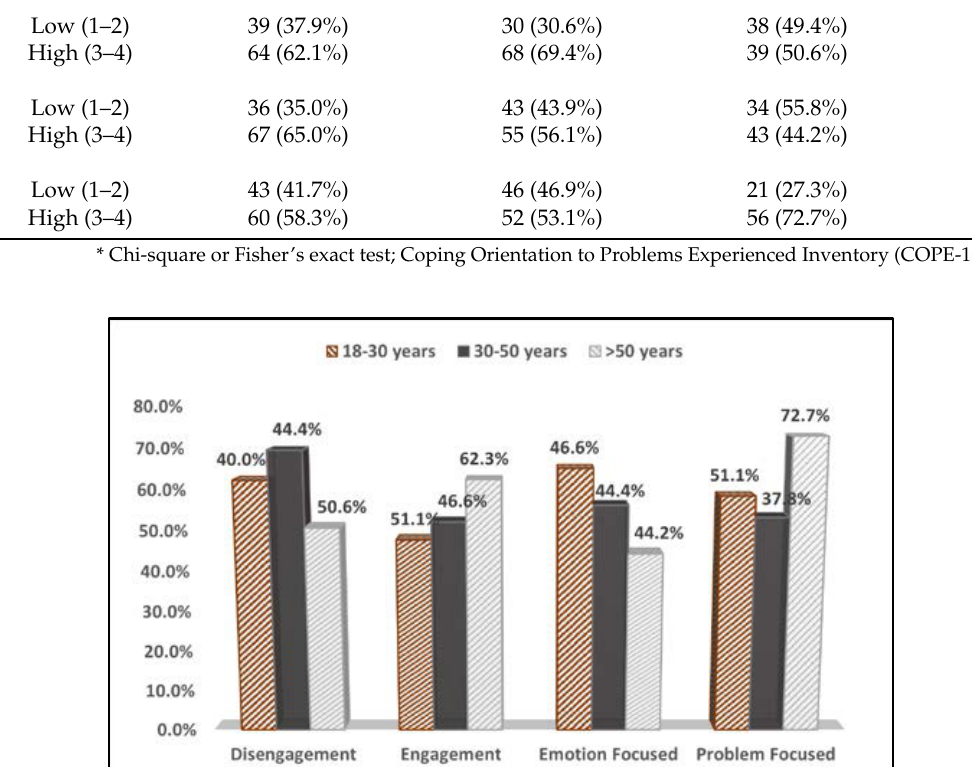
Table 3. Comparison of COPE-60 questionnaire results by age group.